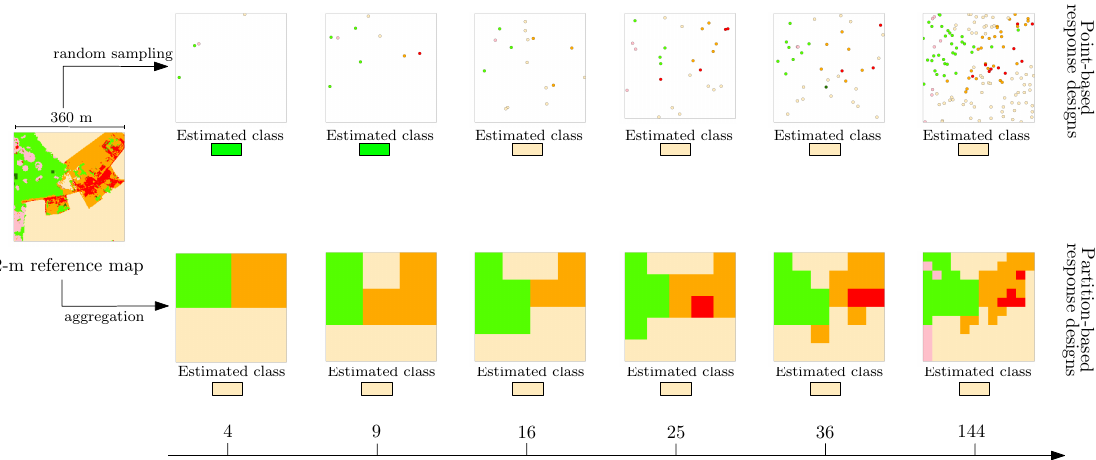
Figure 3. Procedure to generate sampling units and sub-samples from the 2-m reference map. The colors correspond to the multiclass legend of Figure